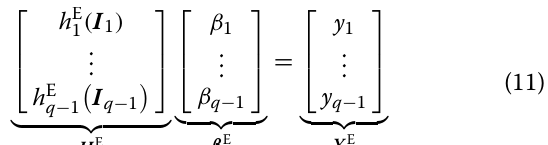
The Eq. (10) can be written as